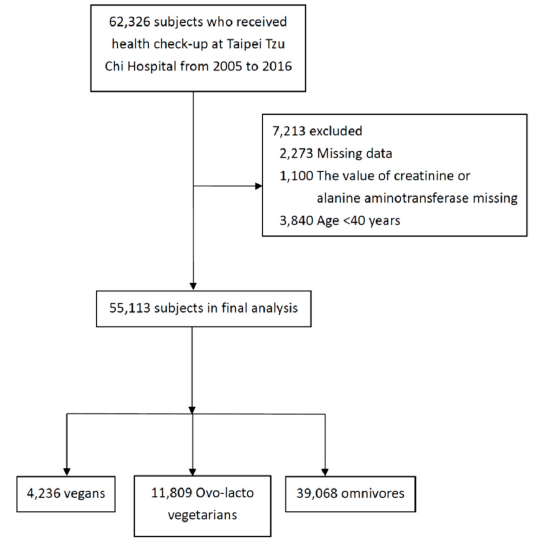
Figure 1. Subject Figure 1. Subject selection.